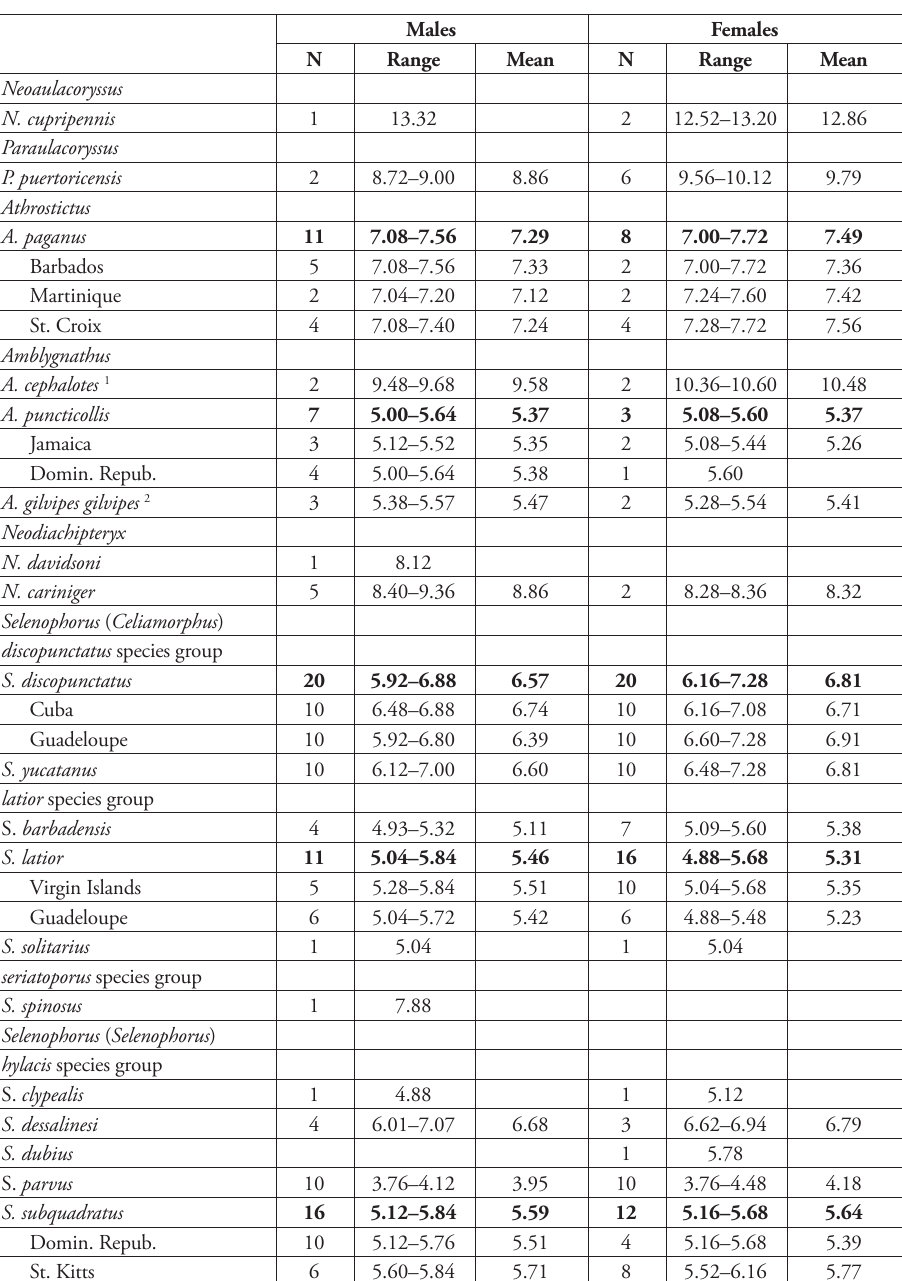
Table 1. Variation in Standardized Body Length (SBL, in mm) among the West Indian species and sub- species of the Selenophori group